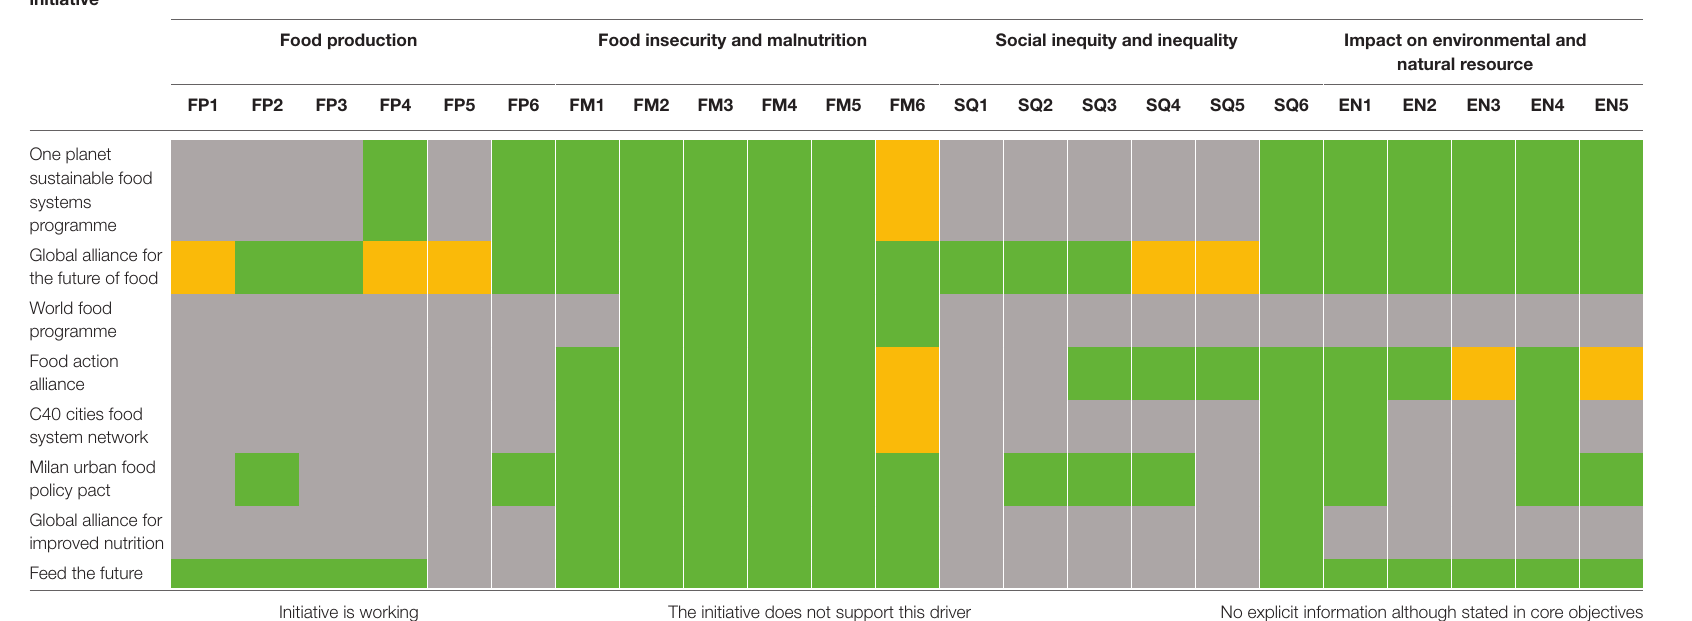
TABLE 8 | Comparison of food system initiatives in addressing food system failures. Food system